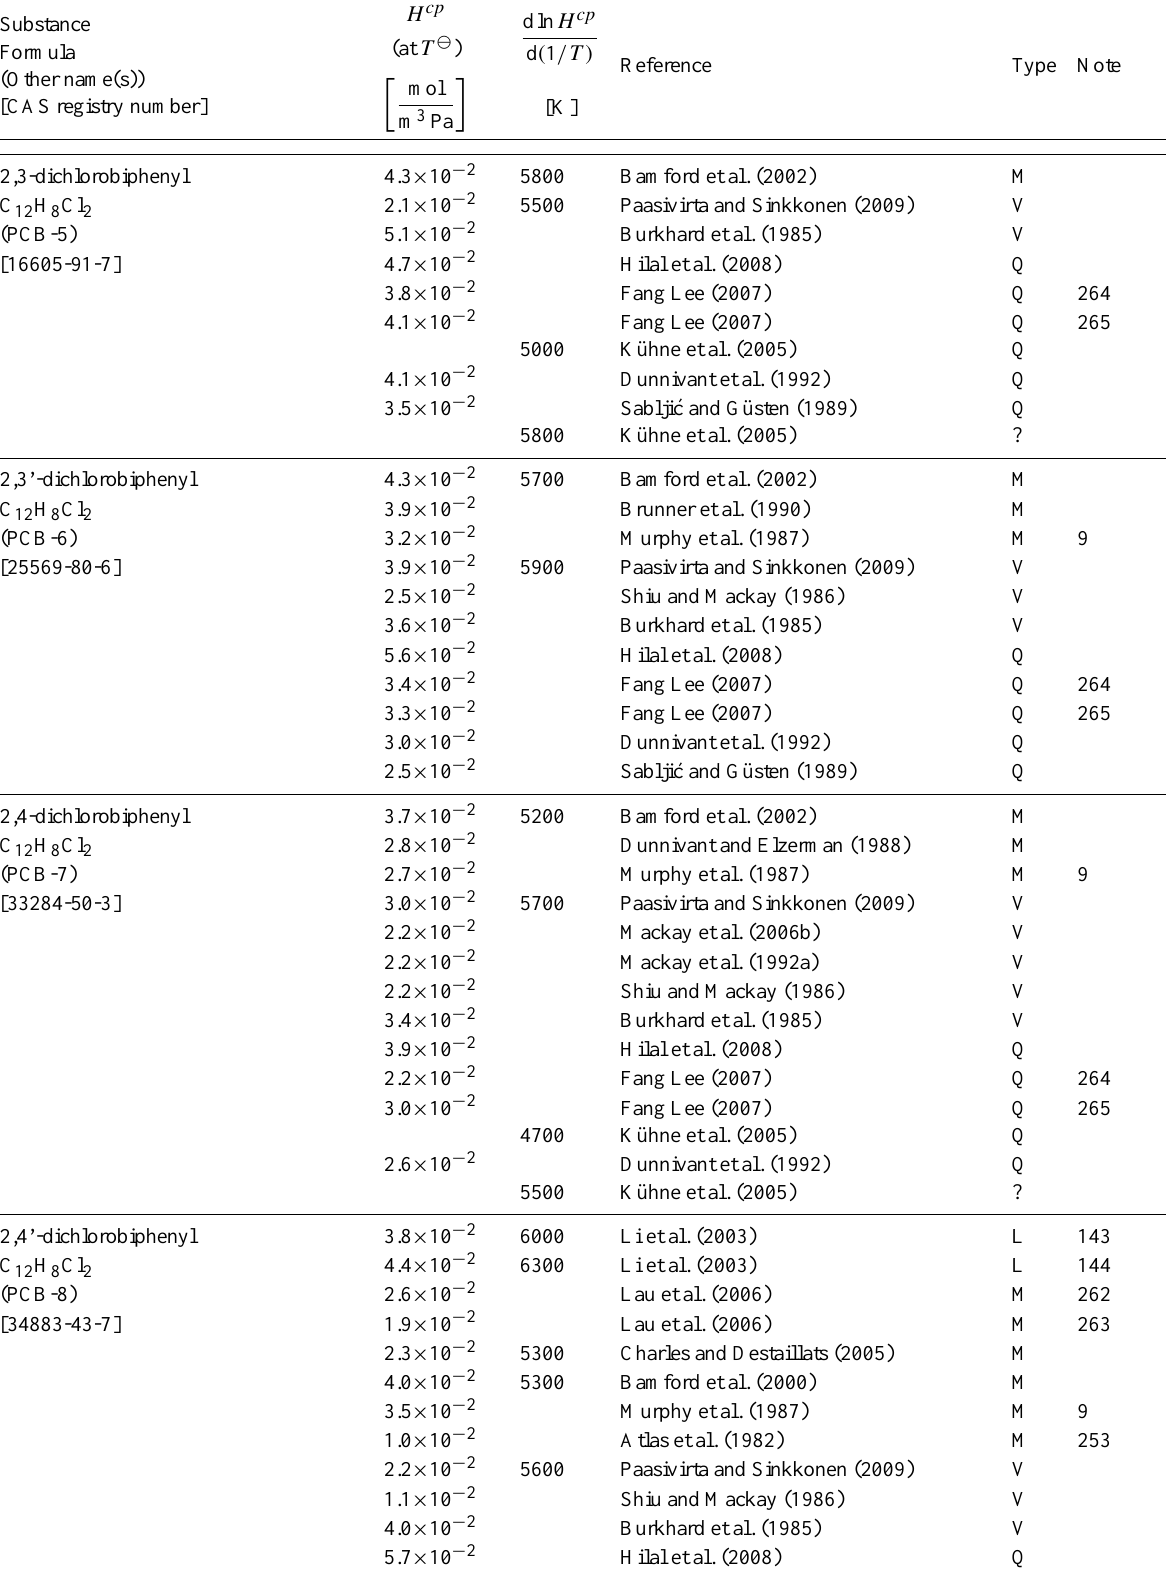
Table 6: Henry’s law constants for water as solvent